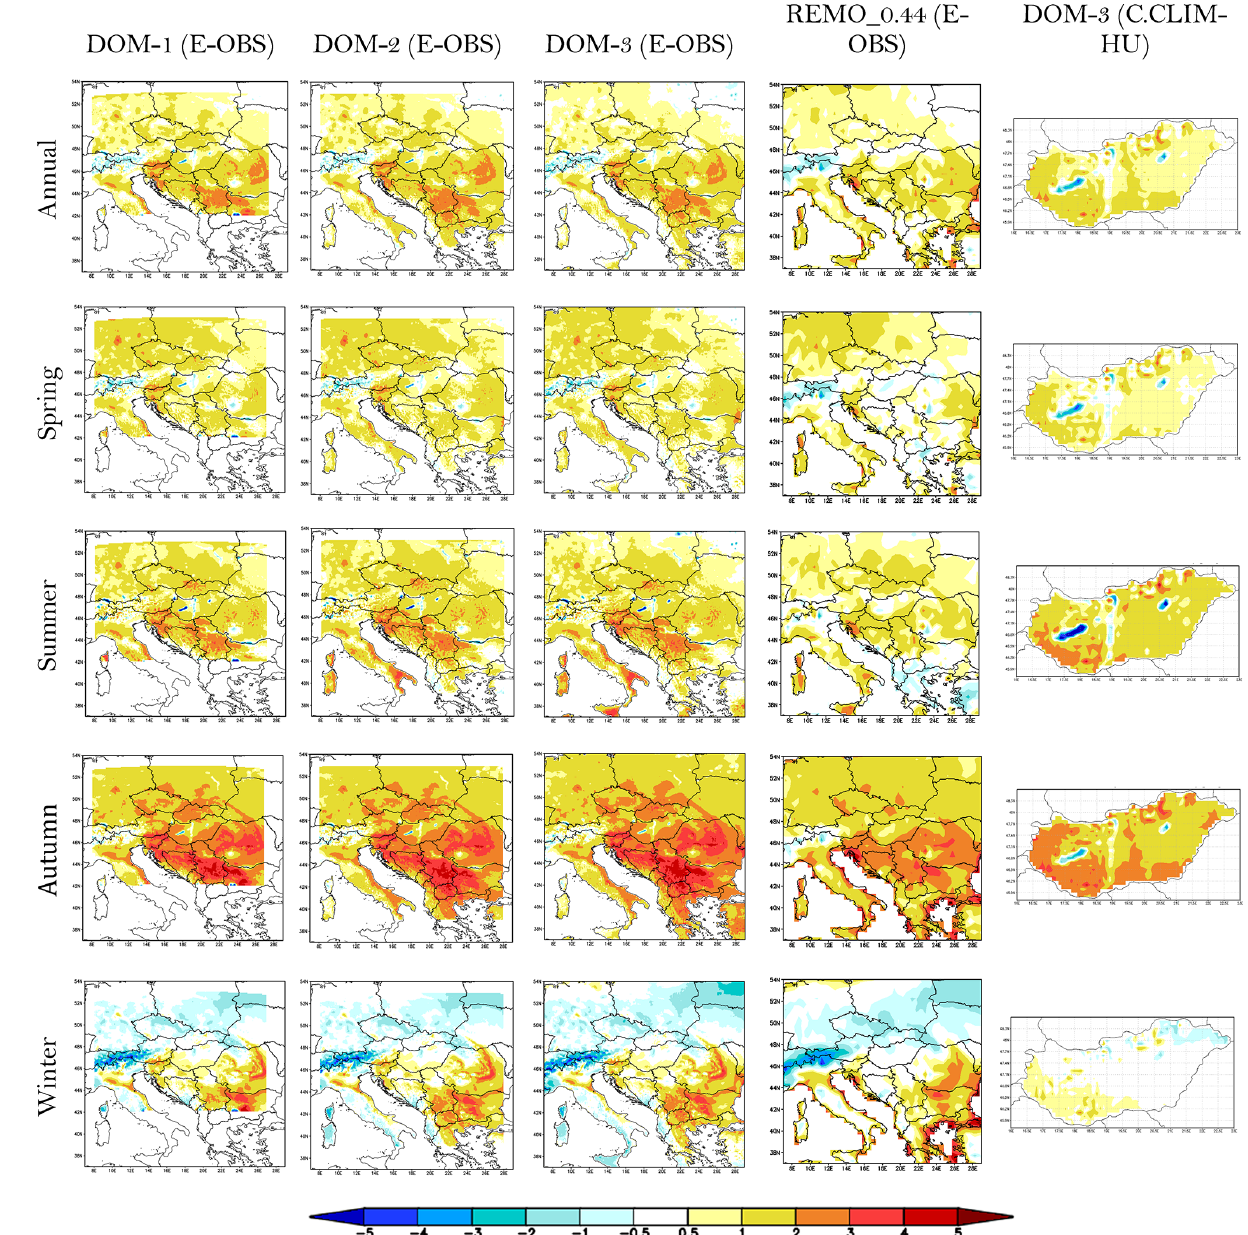
Figure 2. The annual and seasonal temperature bias ( ◦ C) of the REMO model simulations on DOM-1, DOM-2 and DOM-3, and of REMO_0.44 compared to the E-OBS observational dataset (first four columns) and of the DOM-3 experiment compared to CarpatClim- HU (last column). Period: